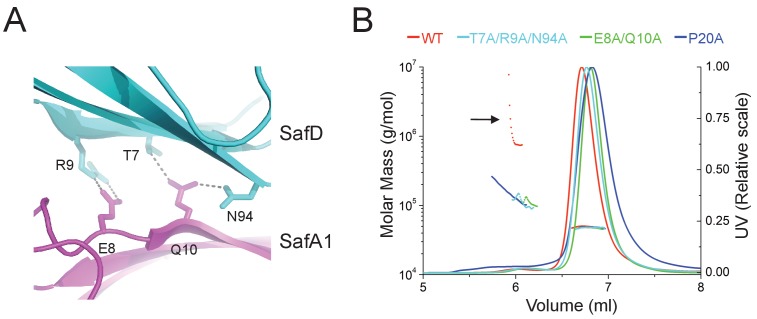
Structural determinants of SafDAA-SafDAA interaction.(A) The inter-molecular hydrogen bonding network in the dimeric interface of SafDAA-SafDAA. As shown in Figure 5B, the SafD-SafA1 intermolecular interaction is repetitive in Type I dimerization. For the purpose of illustration, one dimeric interface is shown. The SafD residues, Thr7, Arg9, Asn94 form four inter-molecular hydrogen bonds with the SafA residues, Glu8, Gln10. The residues are shown in stick representations, and the hydrogen bonds are highlighted with dash lines. (B) SEC-MALS characterization of SafDAA-dsc (red) and mutants (cyan, green and blue) in solution. The elution traces of molecular weight and UV are shown with dashed and solid lines, respective. The self-associating activity, monitored by higher order oligomerization, is highlighted with arrow. The structure-based mutations targeting the dimeric interface and Pro20 significantly impair the SafDAA oligomerization activity.10.7554/eLife.28619.017Figure 6—source data 1.Source data for Figure 6B.Elution volumes and estimatd molecular weights derived from SEC-MALS characterization for WT SafDAA-dsc and mutants.